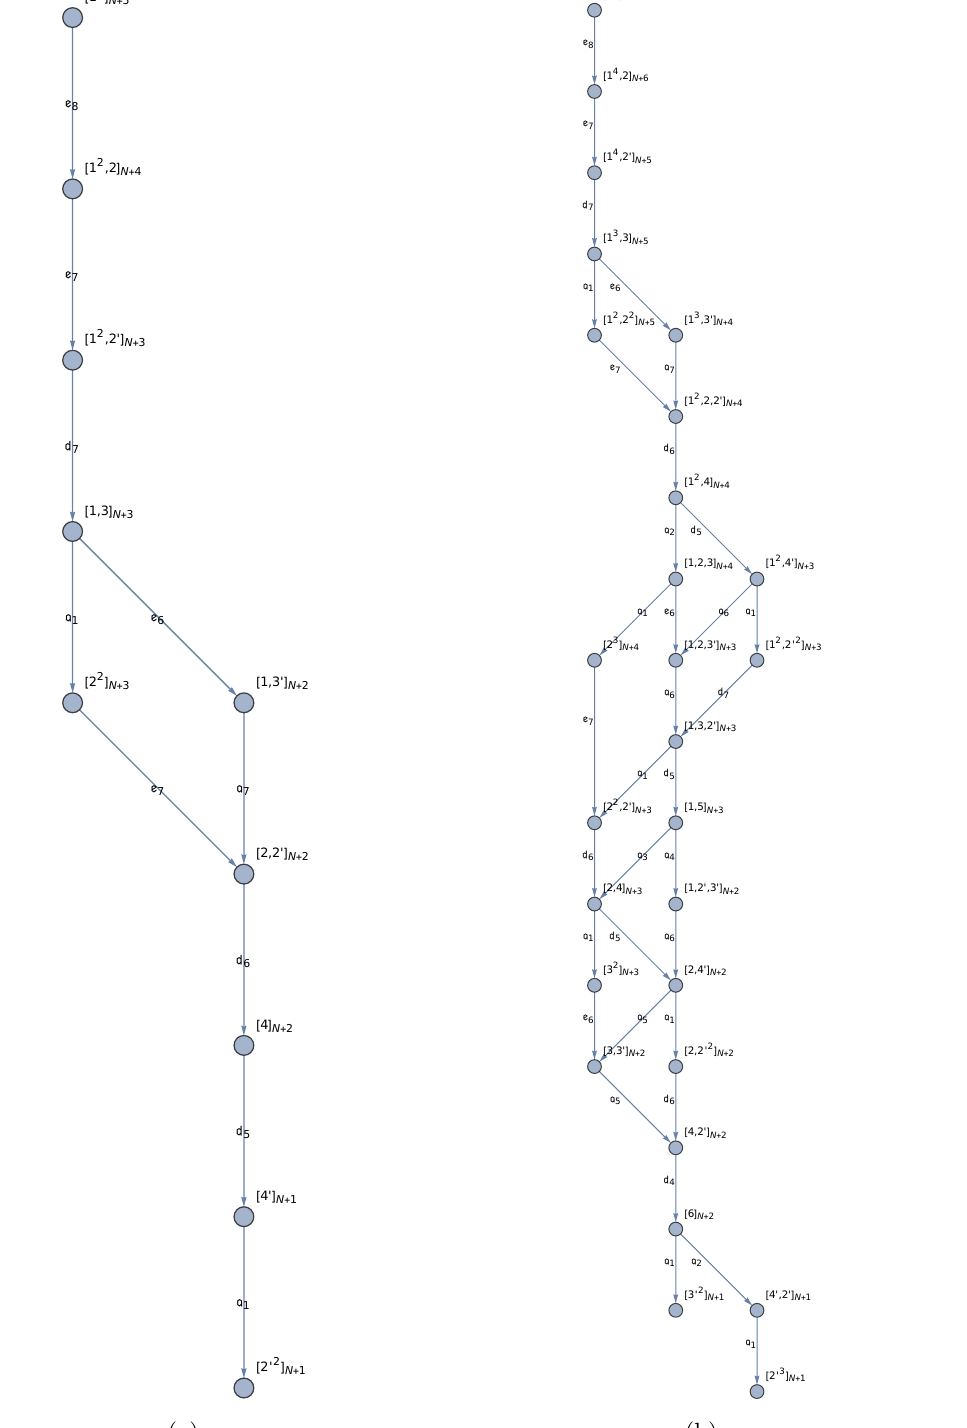
-theories with n = 1 and k = 7 (i.e. 8 0